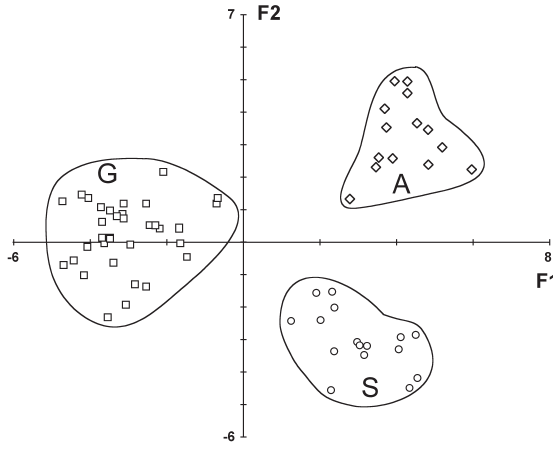
F IG . 10. – Canonical analysis based on the two discriminant func- tions F1 and F2. S: Haplosyllis spongicola, G: Geminosyllis granulosa sp. nov.; A: Geminosyllis sp.